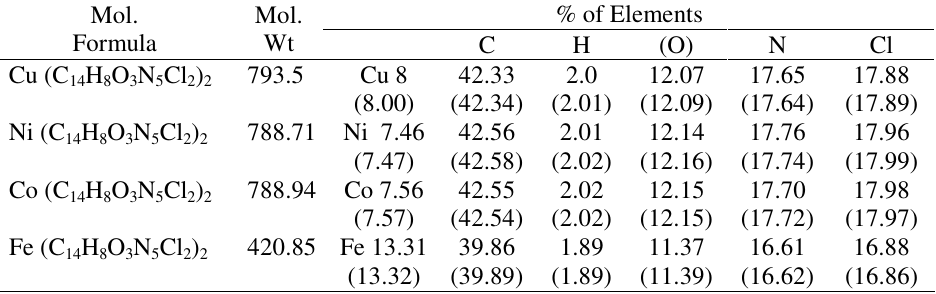
Table 1. Chelates with 7-hydroxy-8-aceto– N -(4’6’-dichloro 1’,3’,5’- s -triazino)coumarin hydrazone (Figures in bracket resembles theoretical values in the